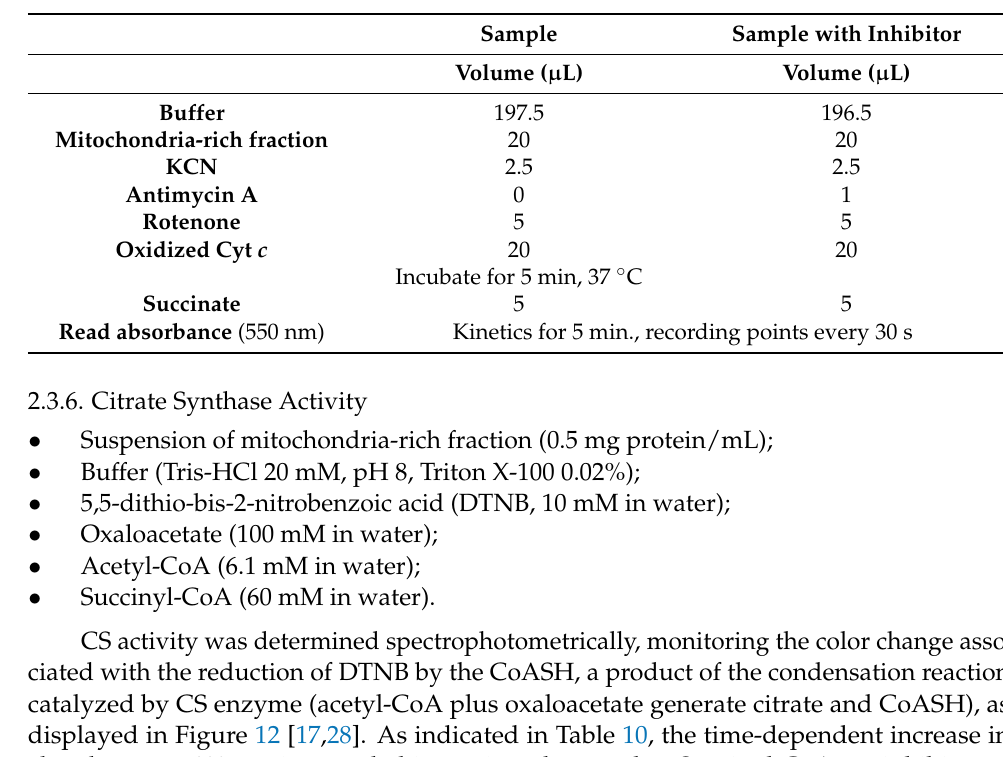
Table 9. Conditions and flow setup for Complex II–III conjugated activity assay.